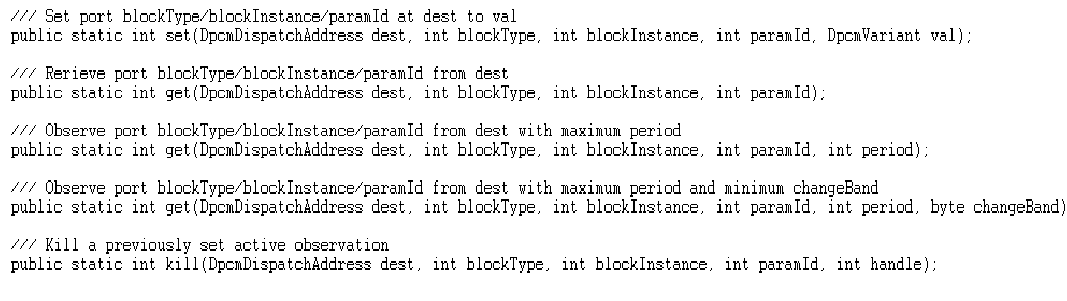
Figure 18. High level MW component remote management API (Hand-held java library).